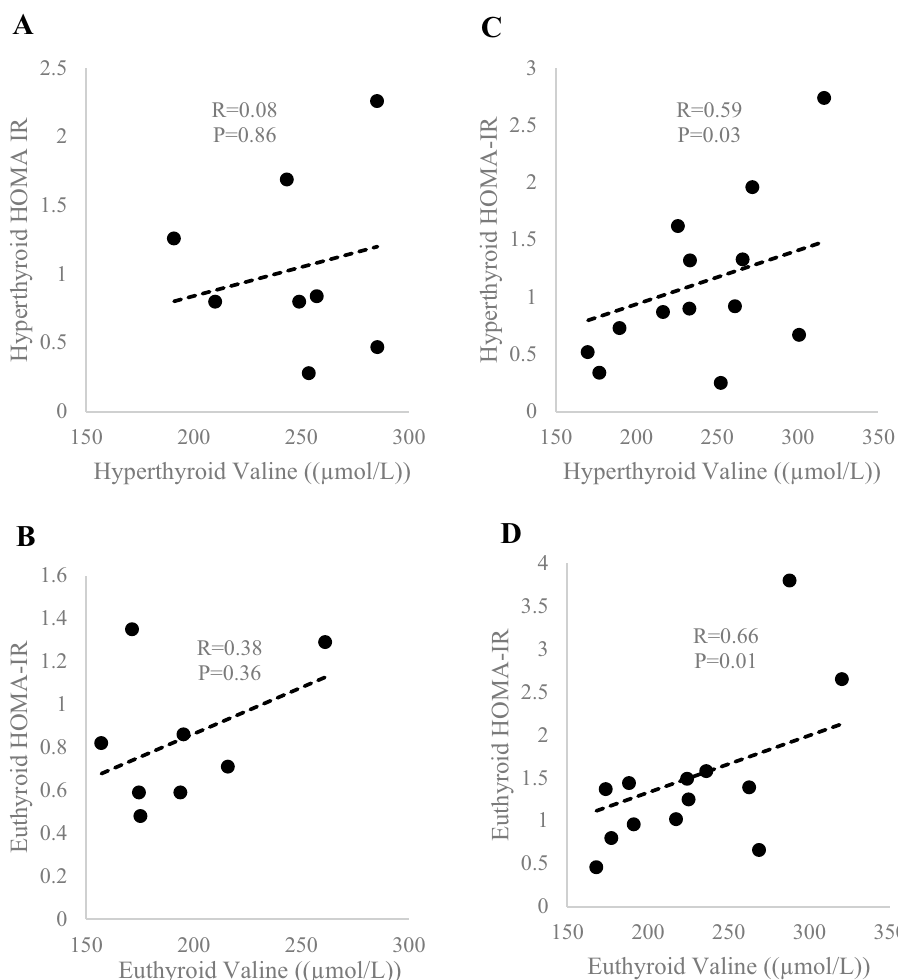
Figure 2. Correlations between valine concentration with HOMA-IR score at hyperthyroid state ( A) and euthyroid state ( B) in BAT-positive subjects and BAT-negative subjects ( C,D) . n = 8 in BAT-positive subjects; n = 13 in BAT-negative